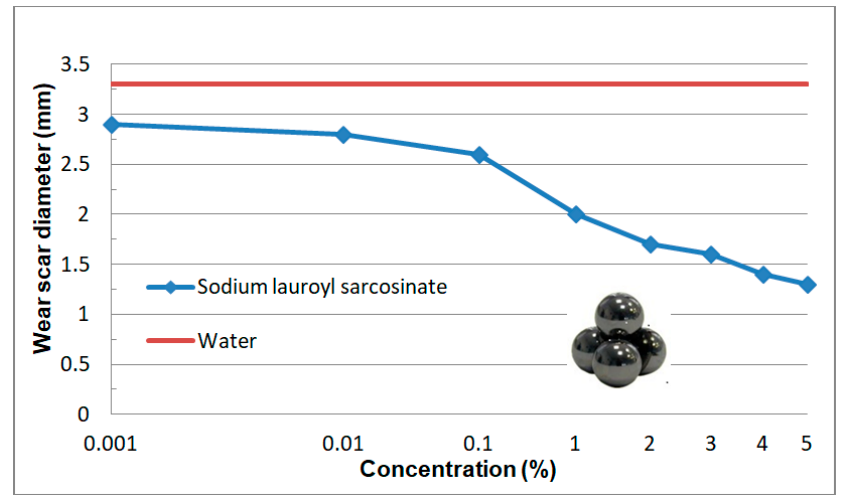
Figure 12. Dependence of wear scar diameter (d oz ) as a function of concentration of sodium lauroyl sarcosinate. Solid line describes d oz value for water (3.3 mm).